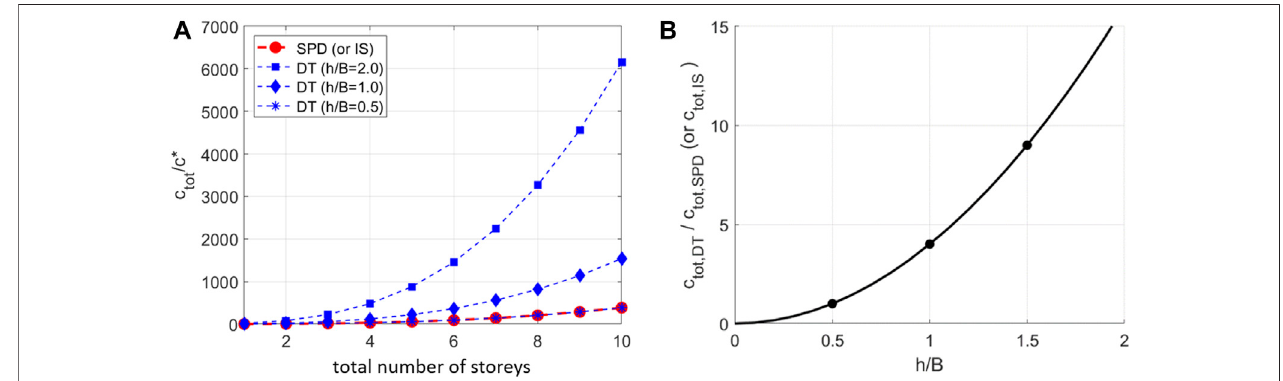
FIGURE 4 | (A) c tot for SPD (or IS) and DT systems vs total number of storeys N ; (B) c tot , DT / c tot , SPD vs. h/B ratio.